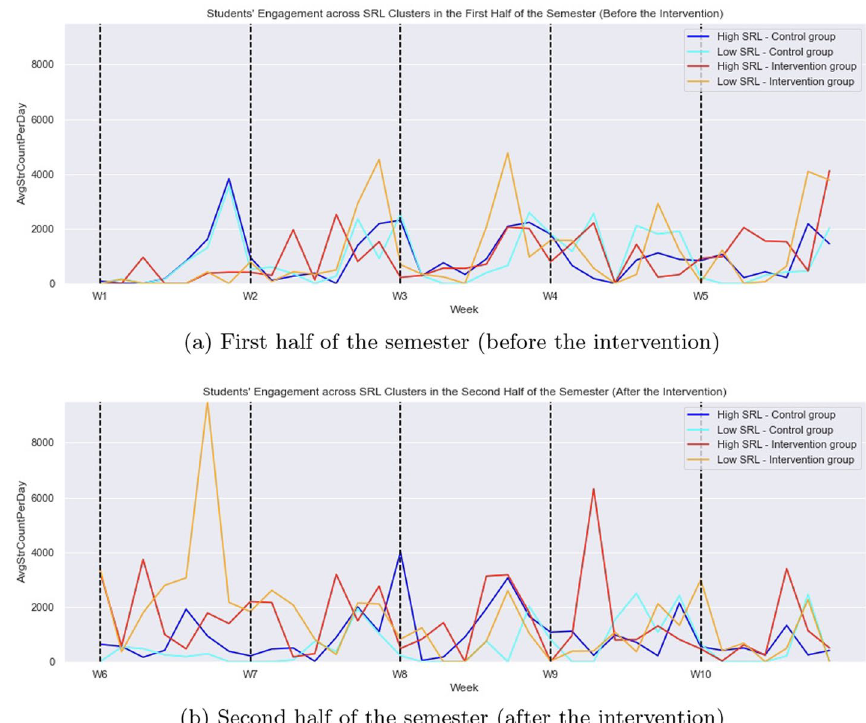
Fig. 4 AvgStrCountPerDay compared high SRL students from the control cohort (blue), low SRL students from the control cohort (cyan), high SRL students from the intervention cohort (red), and low SRL students from the intervention cohort (orange) across